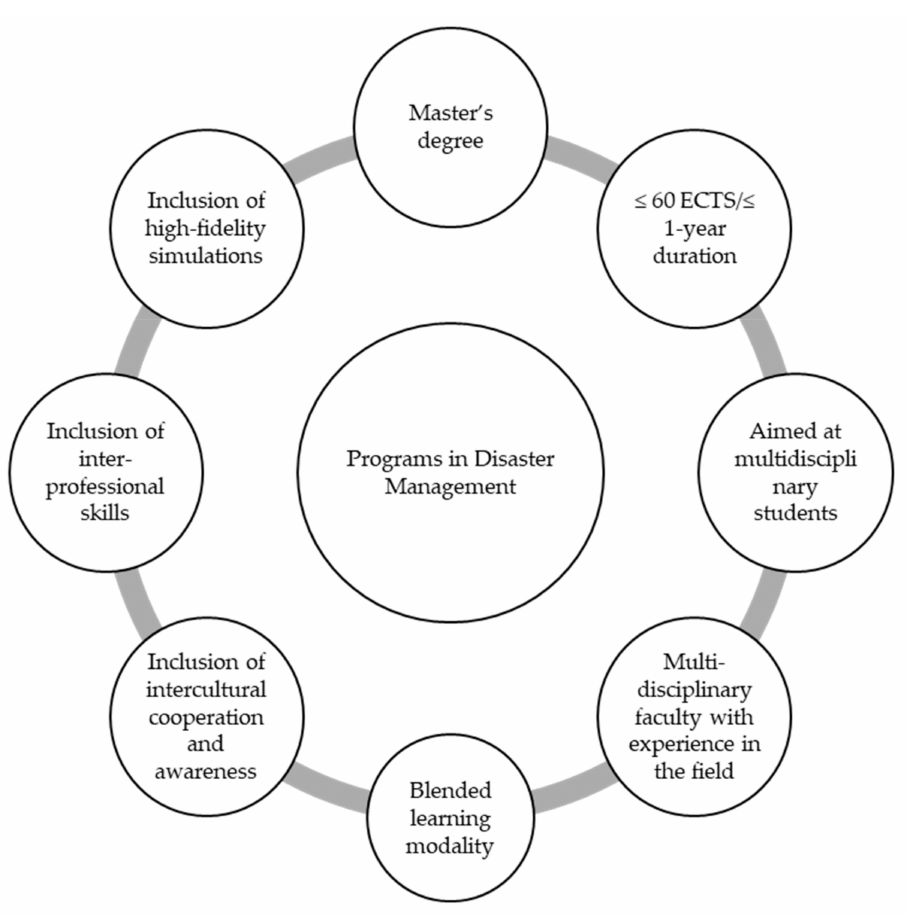
Figure 2. Suggestions to establish and improve the curriculums used in disaster management